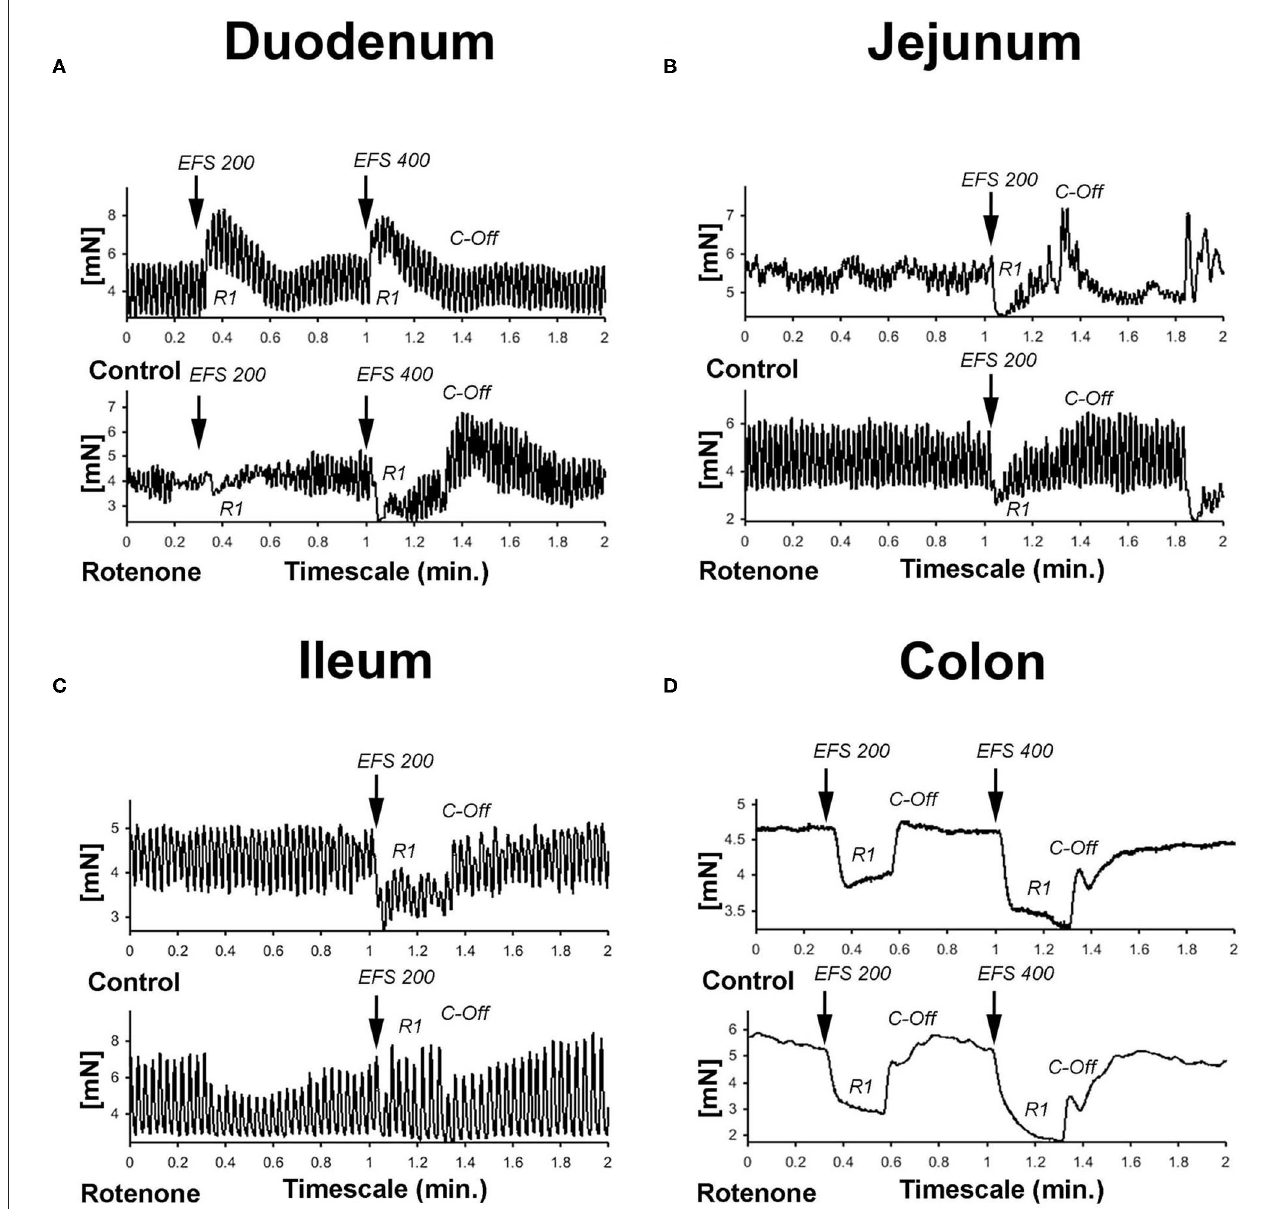
FIGURE 5 | (A–D) Graphic showing representative examples of the force generated by the peristaltic movements and the effect of EFS in the different gut segments in mN. Electric field stimulation normally induces an initial relaxation (R1) followed by a contraction (C-Off) when the stimulus